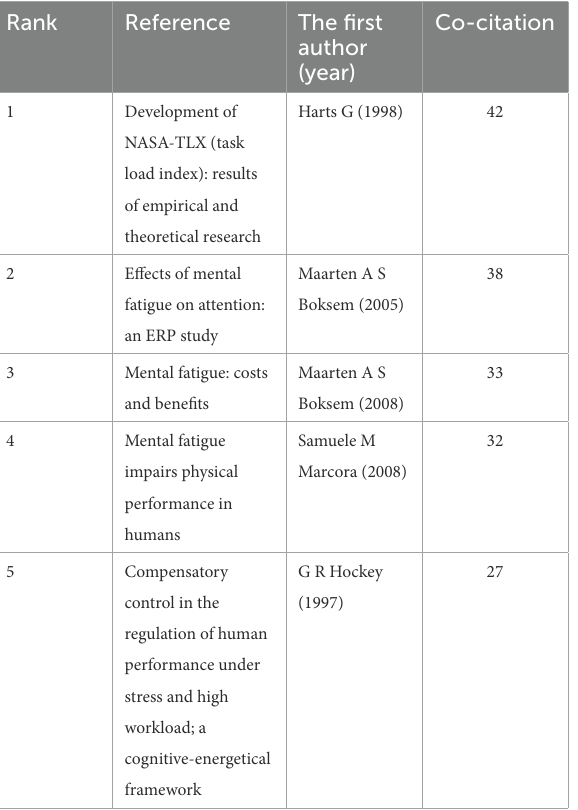
TABLE 7 The top 10 co-occurrence times of